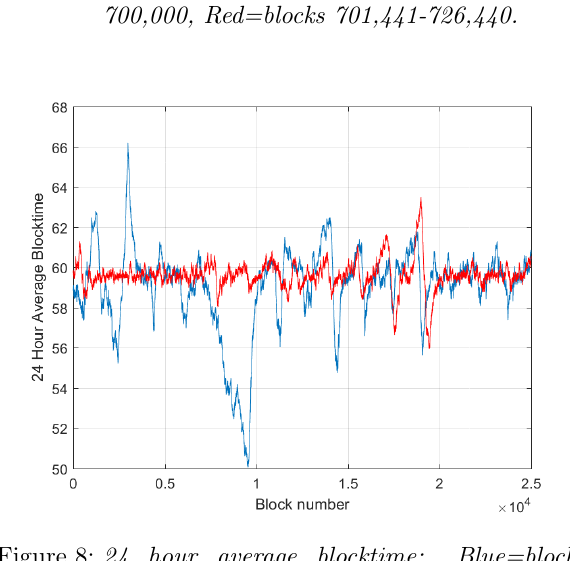
Figure 8: 24 hour average blocktime: